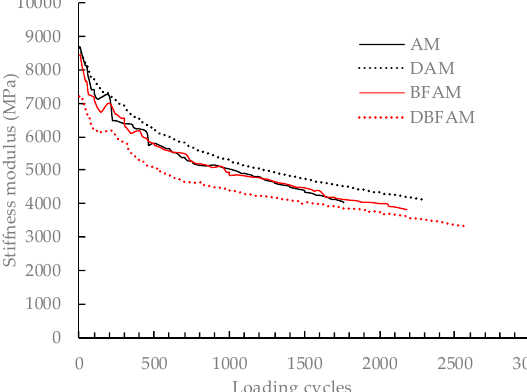
Figure 14. Stiffness modulus under fatigue Figure 14. S tiffness modulus under fatigue test. Figure 14. S tiffness modulus under fatigue test.